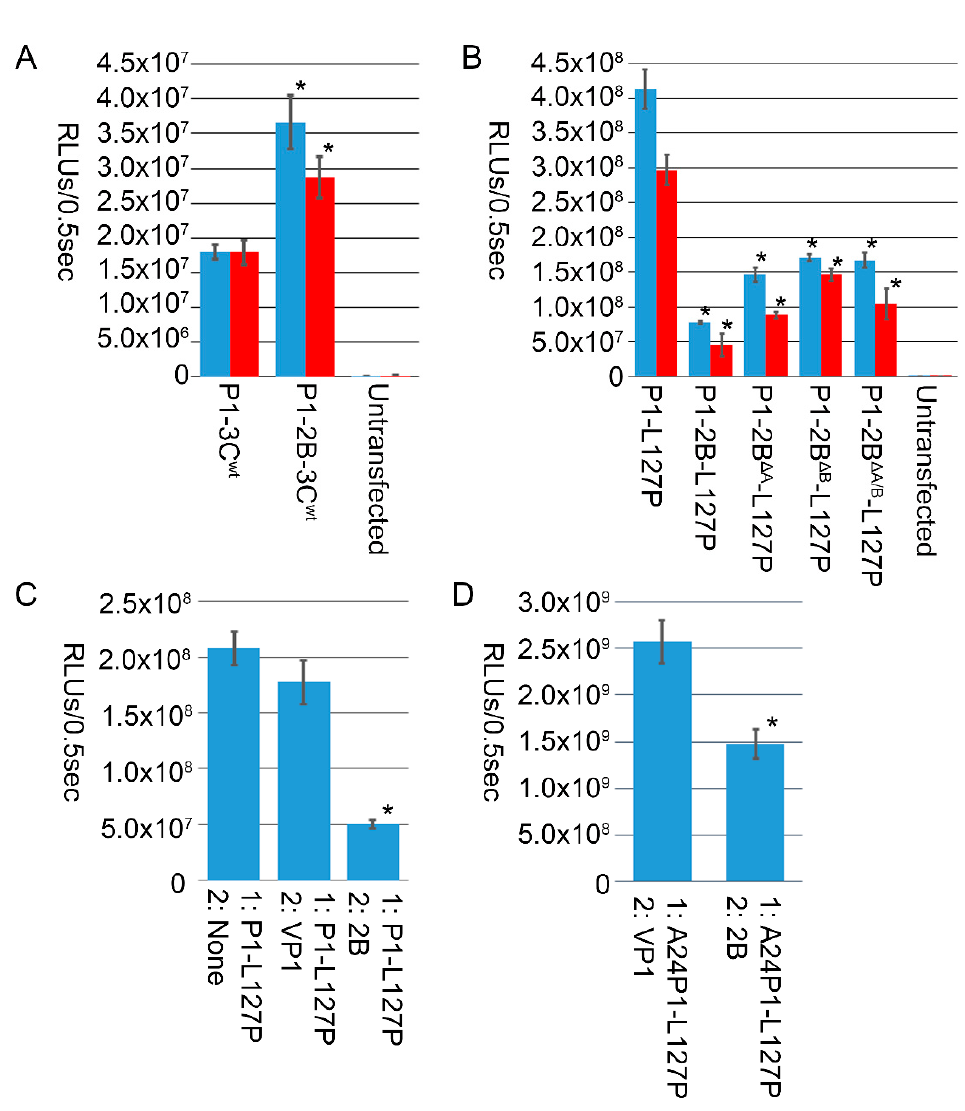
Figure 3. Luciferase activity, in RLUs/0.5 s, for HEK293-T (blue) or CHO-K1 (red) cells